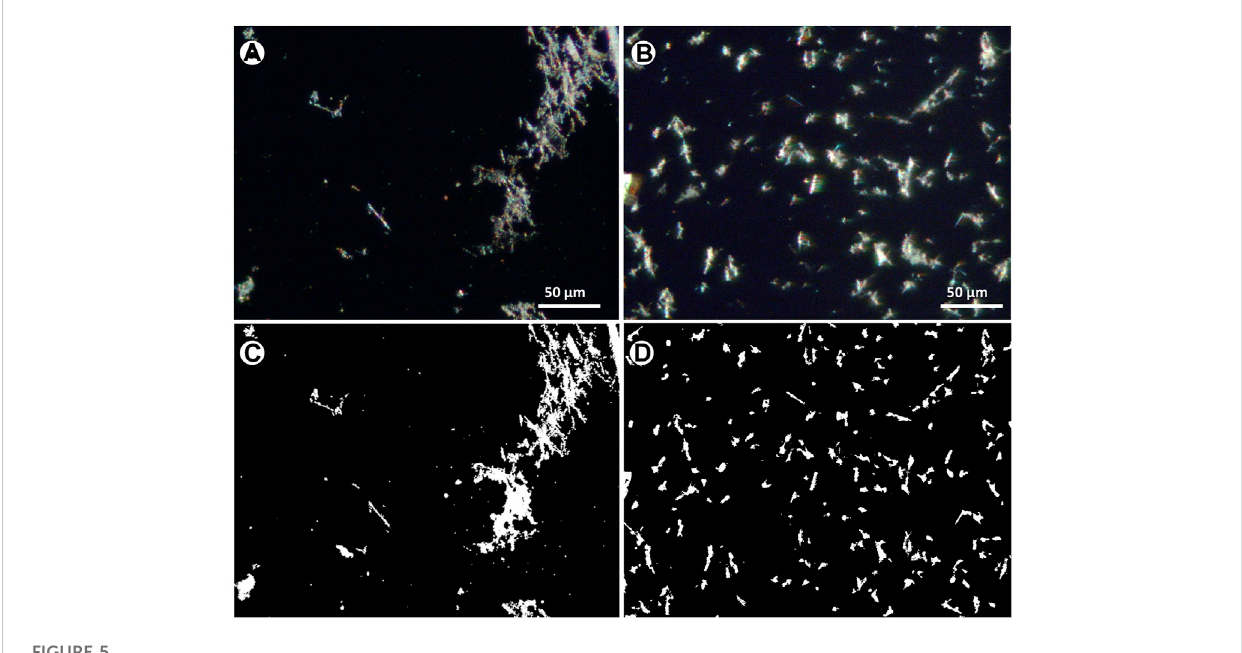
FIGURE 5 Optical images from the same sample of Figure 4, at ×40 magni fi cation, showing the distributions of (A) drop and (B) microdrop methods (C , D) corresponding binary images after thresholding and binarization.